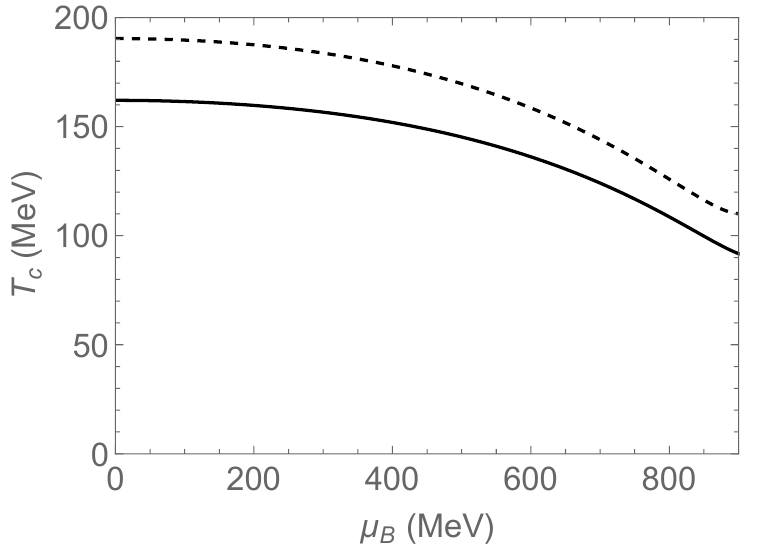
Figure 2. Critical temperature line, T c ( µ B ) , delineating the boundary of hadronic matter in the excluded volume statistical bootstrap model. The solid line shows the boundary location when all quark model ground states are used at input into the statistical bootstrap; the dashed line shows the boundary when only pions and nucleons are considered as